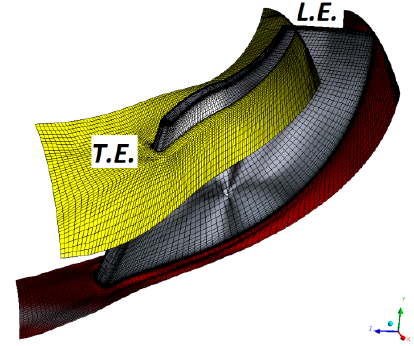
Figure 2. Rotor channel structured mesh with volume mesh cut plane (yellow).